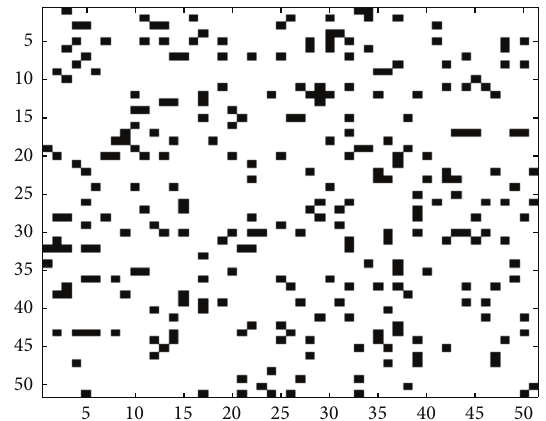
Figure 11: Sparse antenna array configuration: in black (1 = on); in white (0 = off).